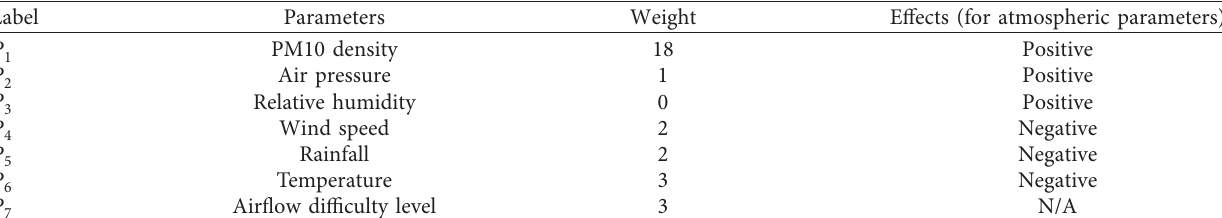
Table 15: Parameters and optimum weights for the identification of the most hazardous location.